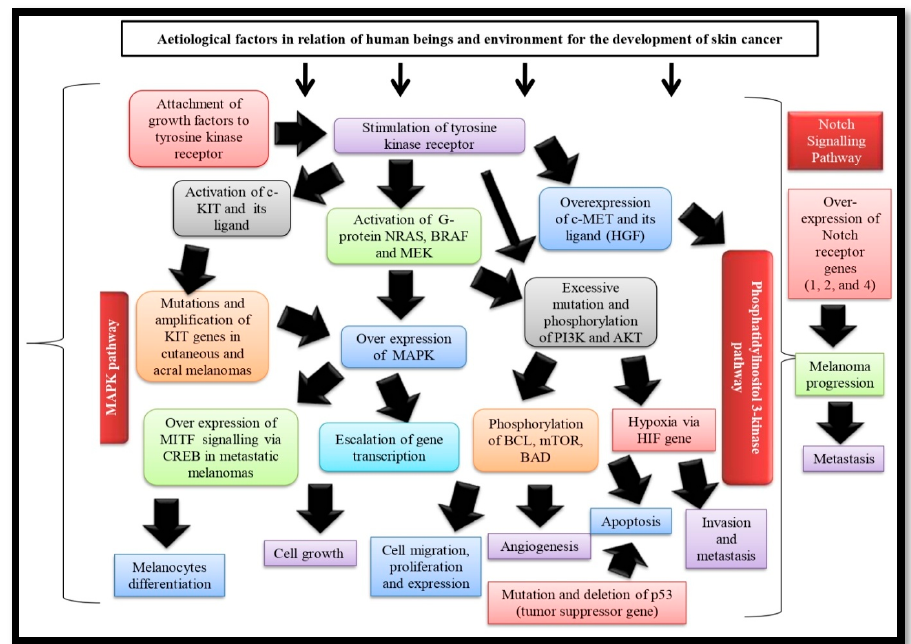
Figure 2. Pathogenesis, signaling and cellular pathways skin cancer. NRAS: Neuroblastoma RAS viral oncogene homolog. PI3K: Phosphoinositol-3-kinase AKT: Protein kinase B. mTOR: The mechanistic target of rapamycin BCL-2: B-cell lymphoma-2. BAD: Proapoptotic protein. NRAS—Neuroblastoma RAS viral oncogene homolog. BRAF: v-Raf murine sarcoma viral oncogene homolog B. MEK: Mitogen-activated protein kinase kinase. MAPK: Mitogen-activated protein kinase.